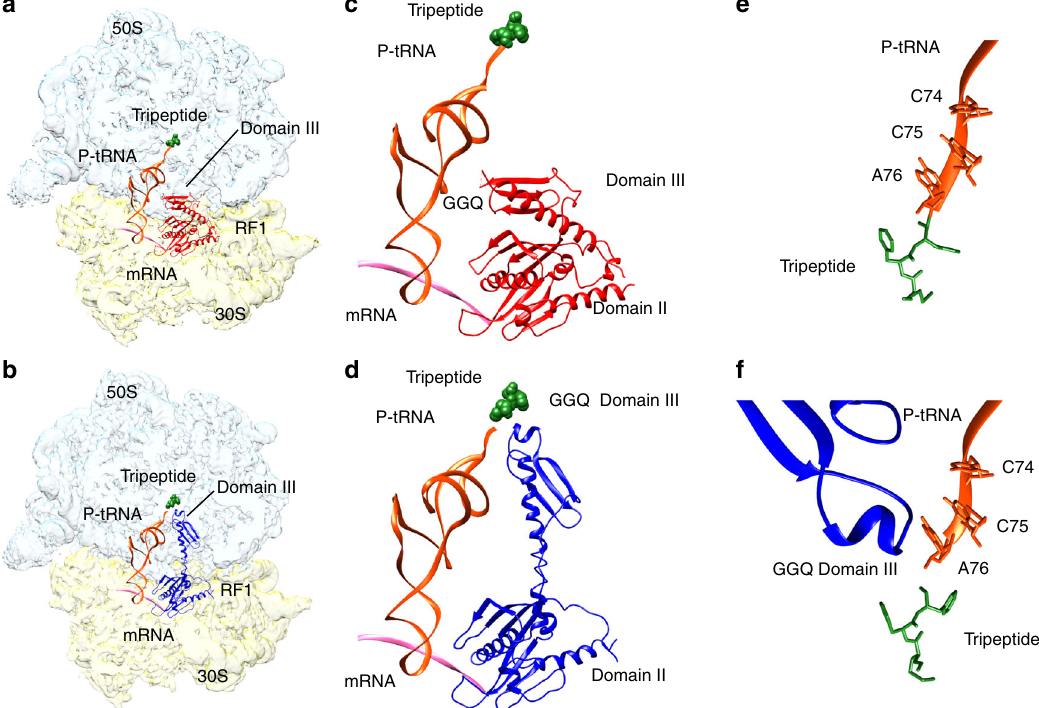
Fig. 2 Cryo-EM structures of E.coli 70S ribosome bound with release factor 1. a Pre-accommodated ribosome complex bound with RF1 in a compact conformation. b Accommodated ribosome complex bound with RF1 in an extended conformation. Light blue: 50S large subunit; light gold: 30S small subunit; green: tripeptide; orange: P-tRNA; pink: mRNA; red: compact RF1; and dark blue: extended RF1. c , d Positions of domain III of ribosome-bound RF1 in pre-accommodated ribosome complex ( c ) and accommodated RF1-ribosome complex ( d ) relative to mRNA (pink), P-tRNA (orange) and tripeptide (green). e , f Close-up views of the upper peptide exit tunnel, showing tripeptide (green) in pre-accommodated ribosome complex ( e ) and accommodated ribosome complex ( f )